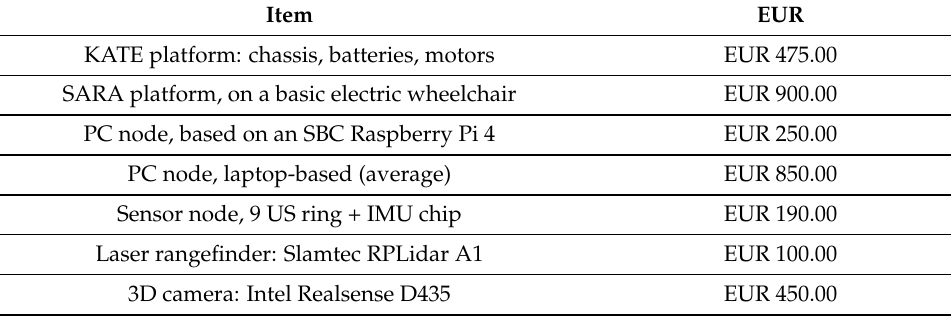
Table 3. KATE and SARA: cost estimation of materials and components. Item EUR KATE platform: chassis, batteries, motors EUR 475.00 SARA platform, on a basic electric wheelchair EUR 900.00 PC node, based on an SBC Raspberry Pi 4 EUR 250.00 PC node, laptop-based (average) EUR 850.00 Sensor node, 9 US ring + IMU chip EUR 190.00 Laser rangefinder: Slamtec RPLidar A1 EUR 100.00 3D camera: Intel Realsense D435 EUR